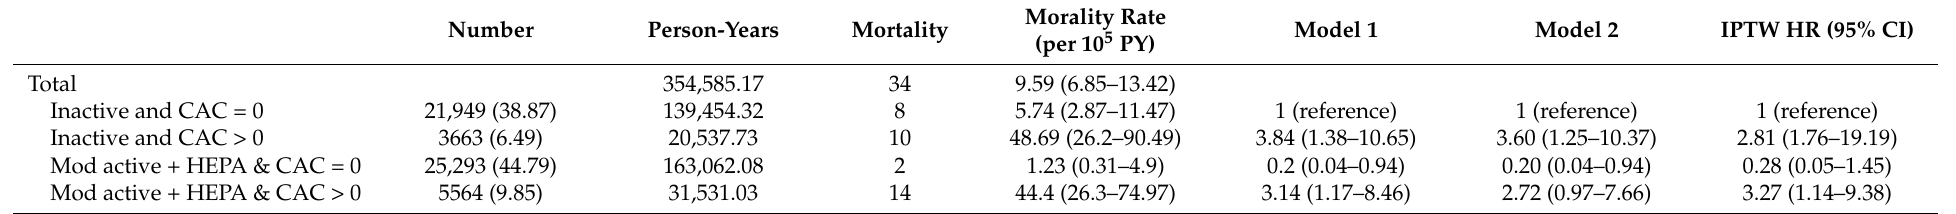
Table 4. Mortality rates based on physical activity levels and CAC: physically inactive without CAC as a